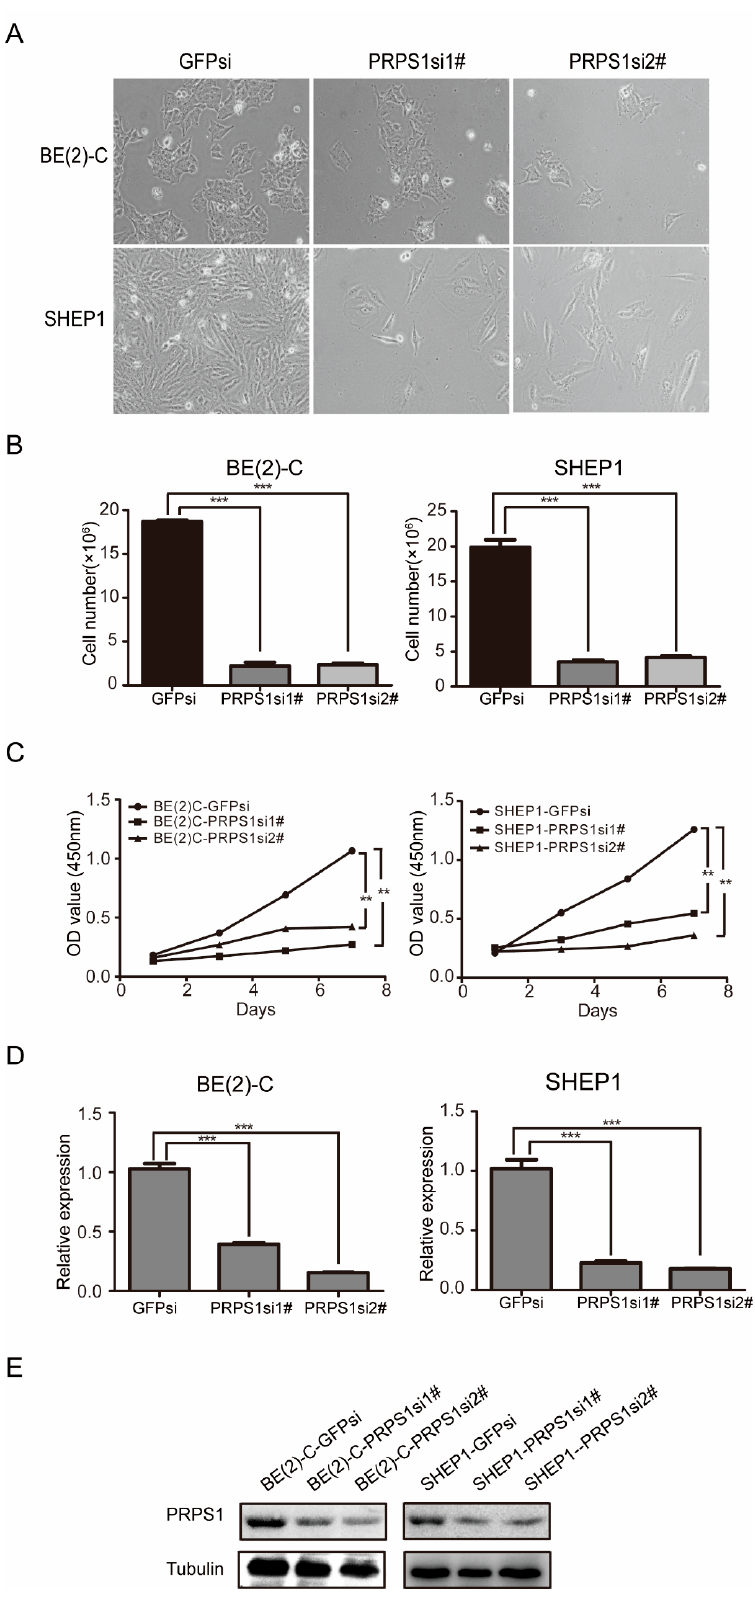
Figure 2. Down-regulation of PRPS1 inhibits neuroblastoma cell proliferation. ( A ) Morphological examination of neuroblastoma cells with either a GFP or PRPS1 knockdown. Scale bar: 20 µ m. ( B ) Cellular enumeration with trypan blue dye staining. ( C ) Neuroblastoma cell growth curves